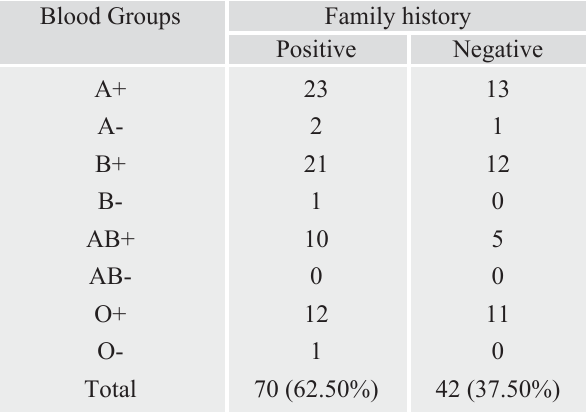
Table III: Frequency of metastasis in study subjects